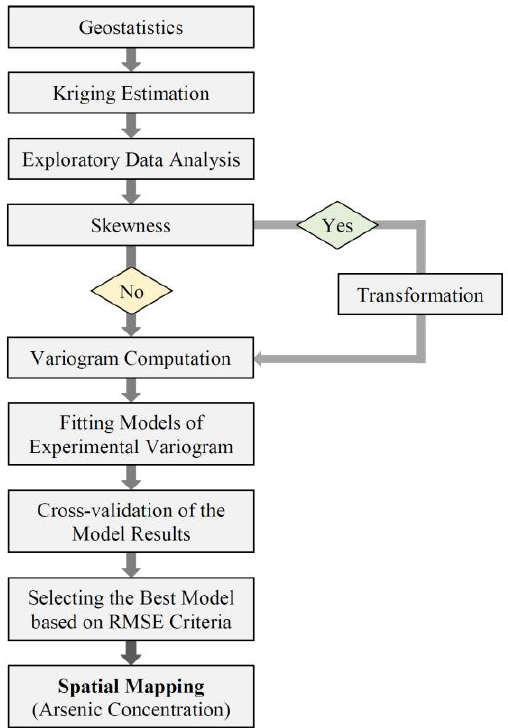
Figure 1. Flow diagram for geostatistical analysis for spatial arsenic